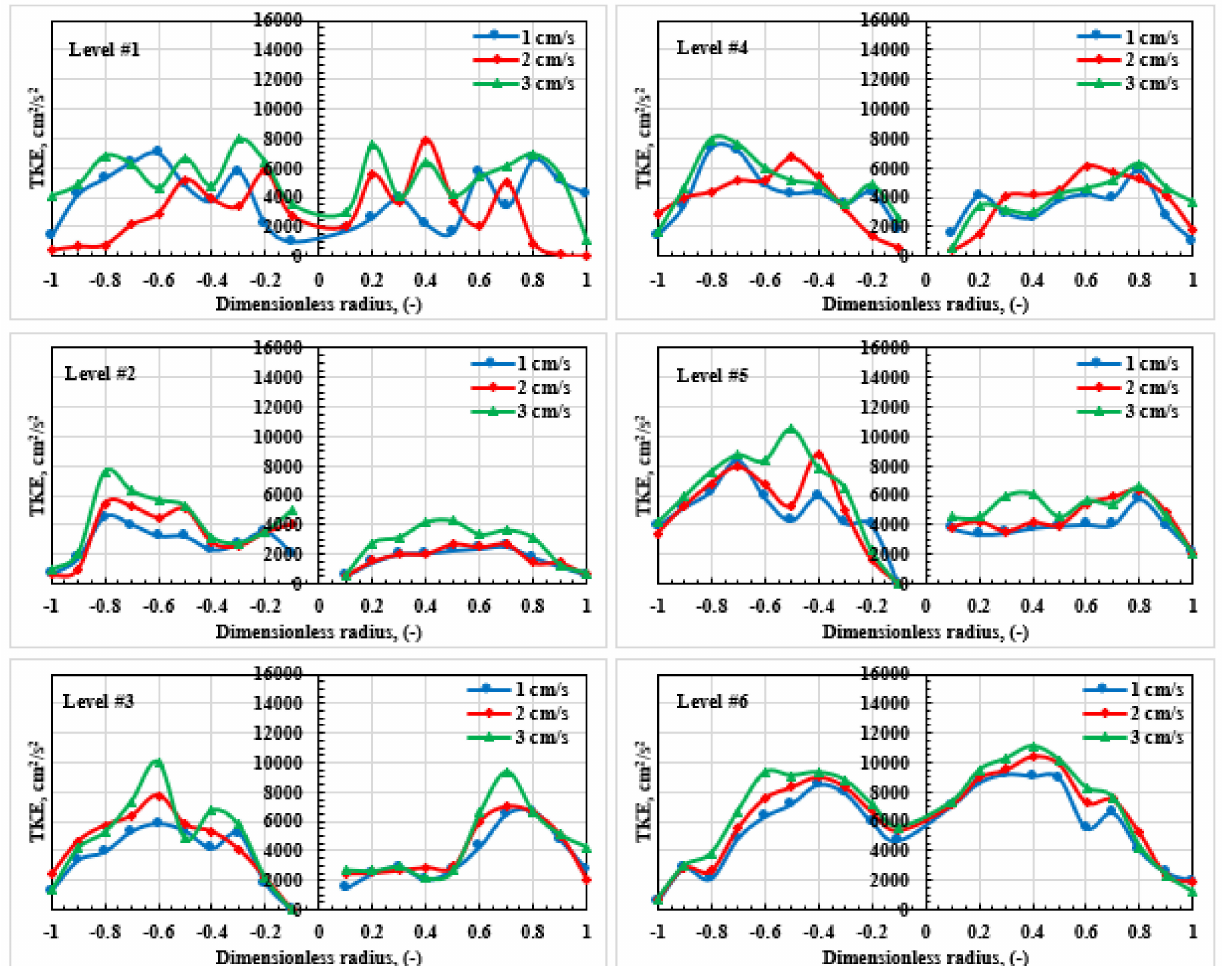
Figure 23. Local turbulent kinetic energy profiles at different height of split airlift reactor operated under different gas